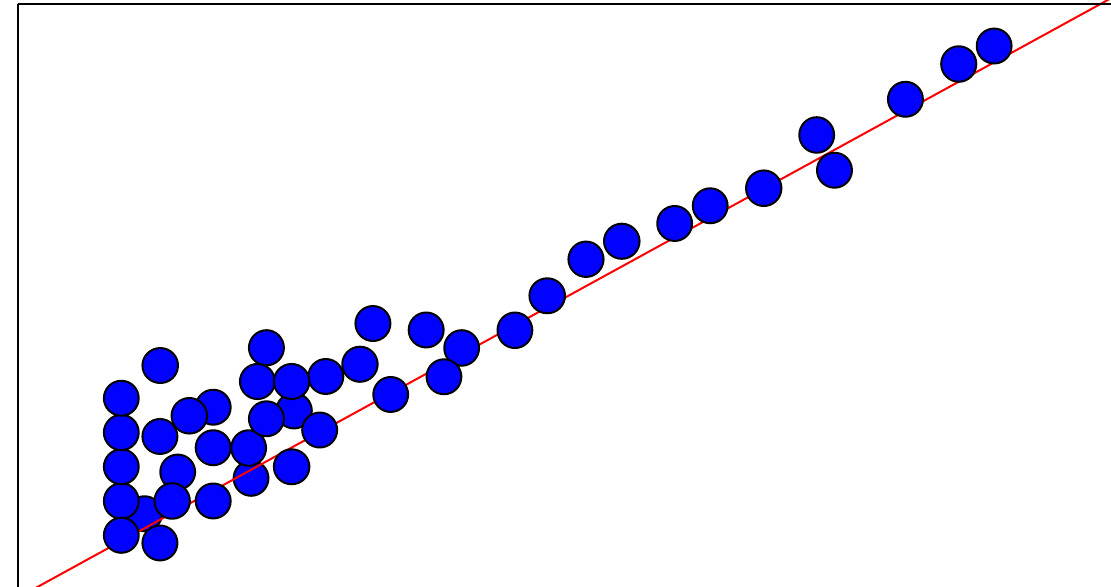
Figure 4. The correlation of predicted logKi (logKi-nn) calculated using NN and observed logKi